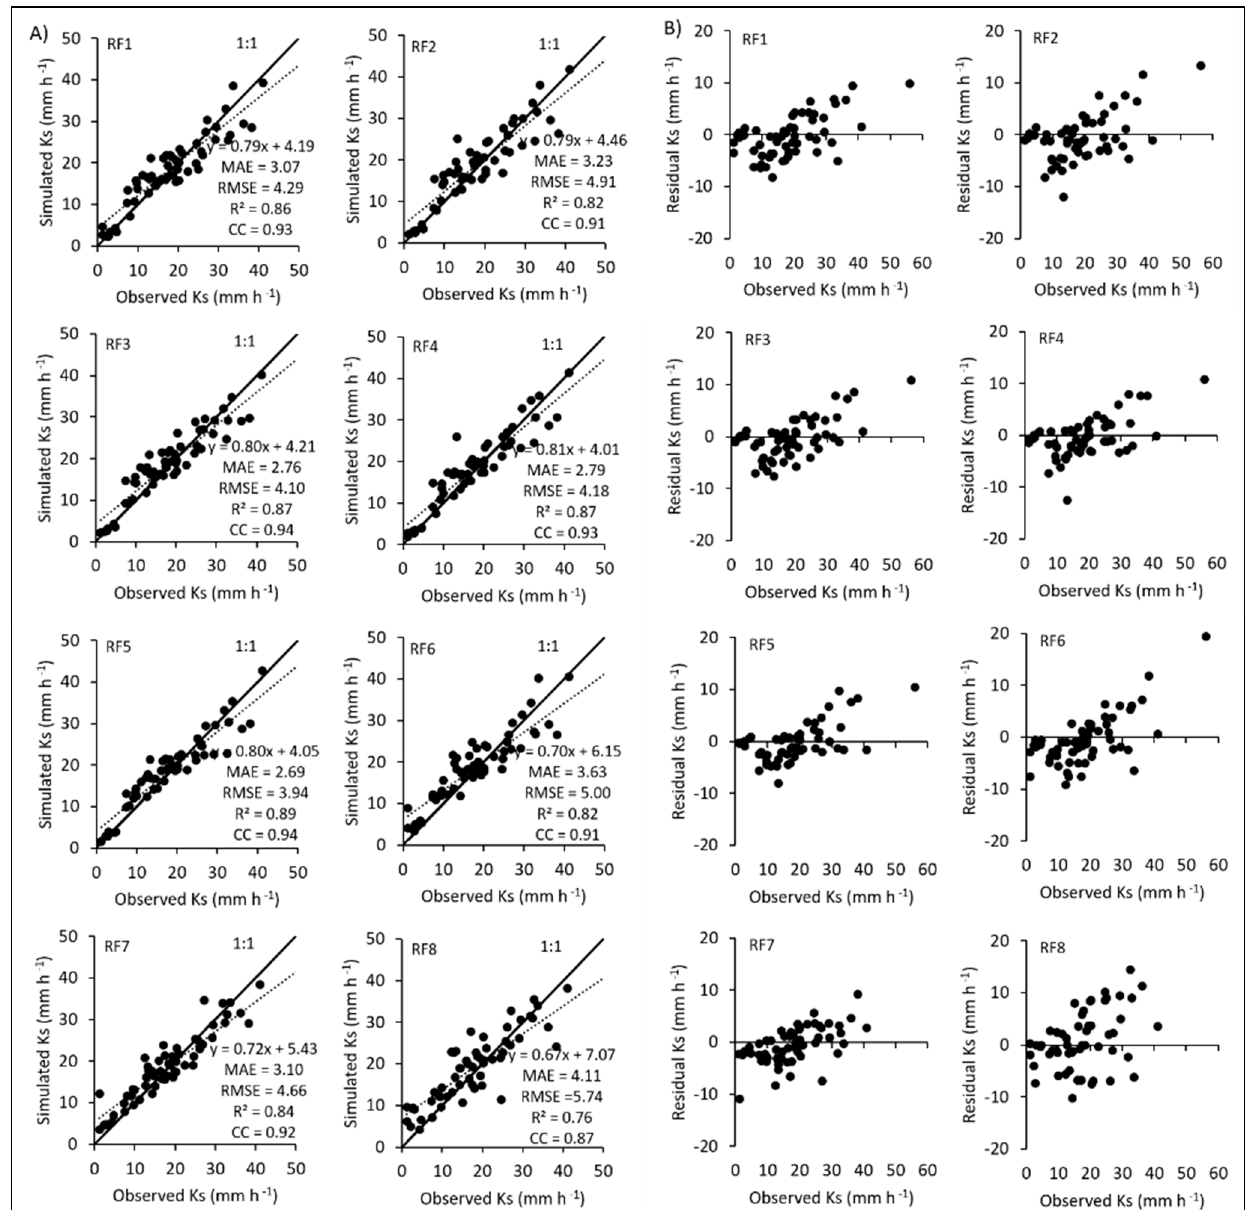
Figure 8. Scatter and residual plots of the RF model with eight combinations of soil input data.